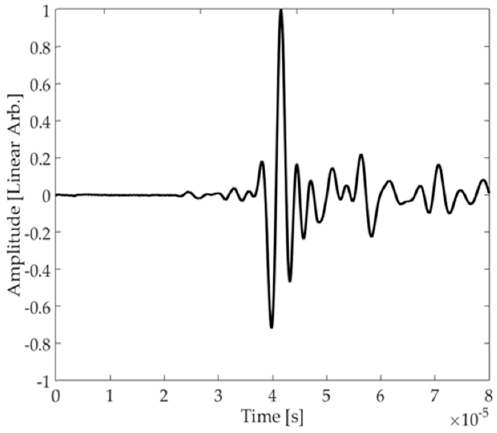
Figure 8. Pitch catch time-trace obtained from Transducer 1–3 in Figure 7.